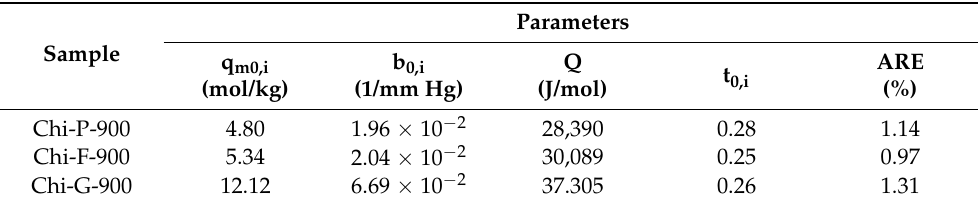
Table 3. Toth model parameters for the CO 2 adsorption of the biochars obtained after the pyrolytic treatment of chitosans with different textural properties at 900 ◦ C (CO 2 adsorption: 25 ◦ C).